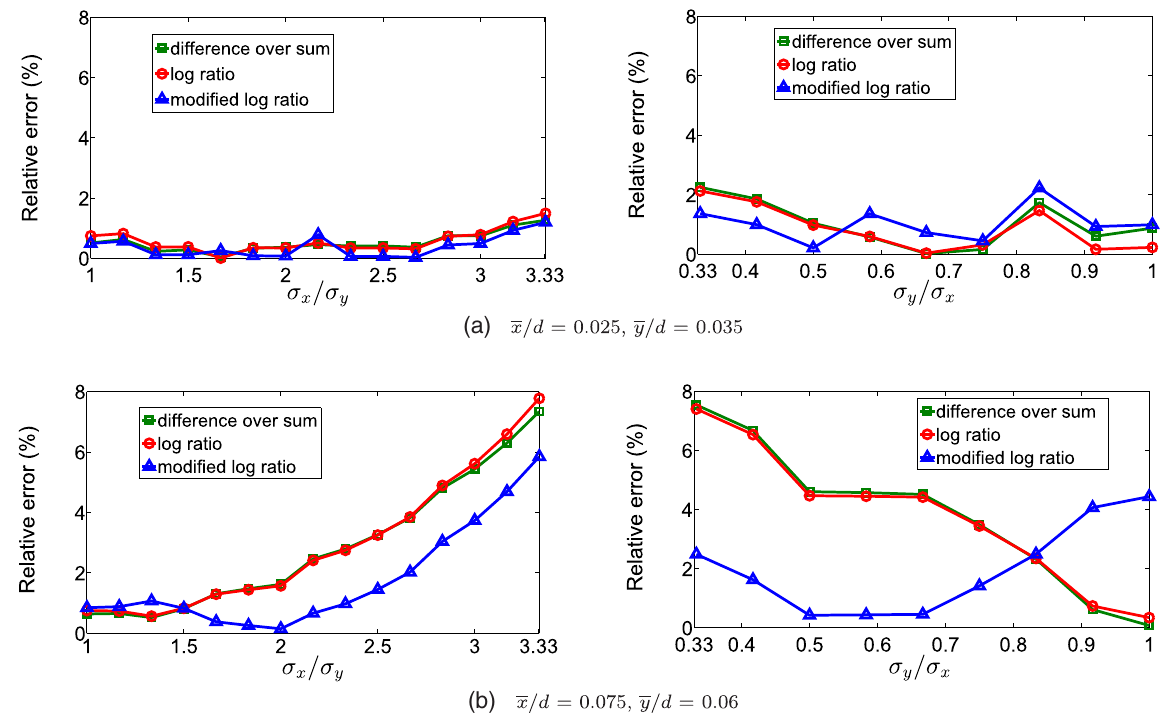
FIG. 17. Absolute value of the relative error of ð σ 2 x − σ 2 y Þ =d 2 from the ideal value: (a) (left) as a function of σ x = σ y , σ y ¼ 7 . 5 mm; (right) as a function of σ y = σ x , σ x ¼ 15 mm; (b) (left) as a function of σ x = σ y , σ y ¼ 7 . 5 mm; (right) as a function of σ y = σ x , σ x ¼ 15